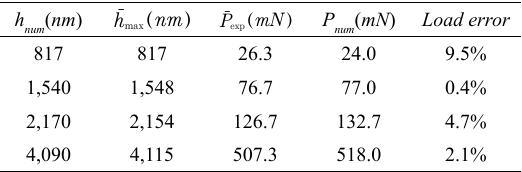
Table 4. Comparisons between experimental and numerical results of Berkovich